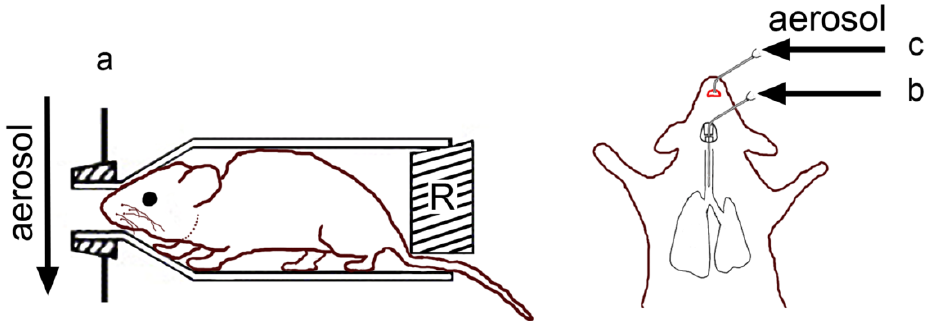
Figure 5. Exposure of rodents to aerosols. (a) nose-only exposure. The restraint (R) prevents loss of aerosol by leakage around the animal. The small opening at the bottom allows temperature regulation of the animal through the tail; Intratracheal instillation (b) and oropharyngeal aspiration (c) uses commercial or self-designed syringes for manual application of